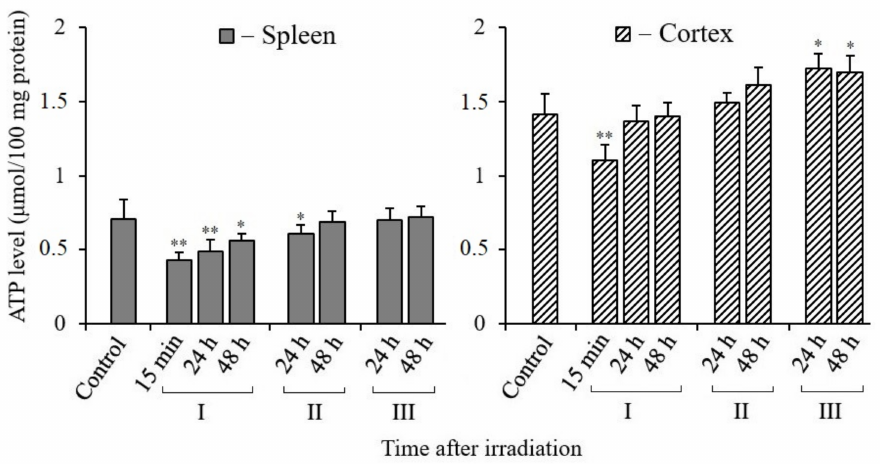
Figure 5. Changes in the ATP content in spleen and cerebral cortex tissues of mice 15 min, 24, and 48 h after their irradiation. I—mice groups without MEL administration; II—MEL administration before irradiation; III—MEL administration after irradiation. The data are presented as mean ± SEM of 5–6 independent experiments. Statistical significance was set at * p < 0.05; ** p < 0.01.